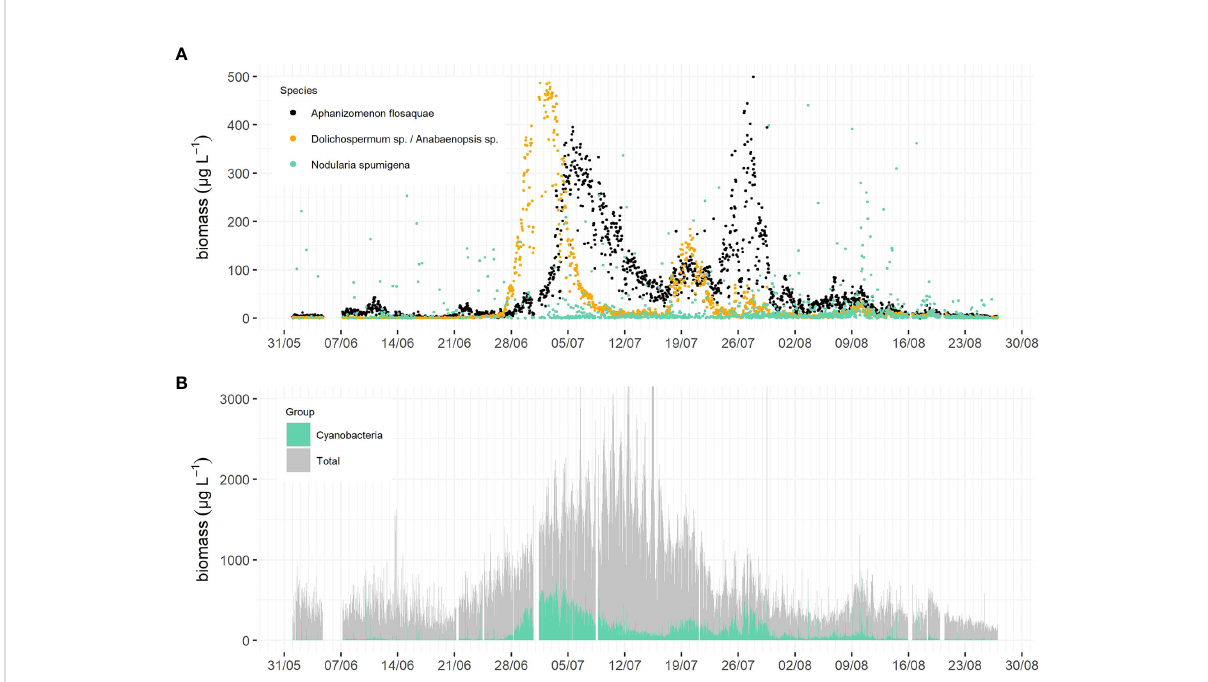
FIGURE 5 The biomasses of the three bloom forming fi lamentous cyanobacteria taxa of the Baltic Sea in summer 2021, black = Aphanizomenon fl osaquae , orange = Dolichospermum sp./ Anabaenopsis sp., green = Nodularia spumigena (A) . The total phytoplankton community biomass (grey) and the total fi lamentous cyanobacteria biomass (green) from the same period (B) . The data was classi fi ed with the automated CNN model in near-real